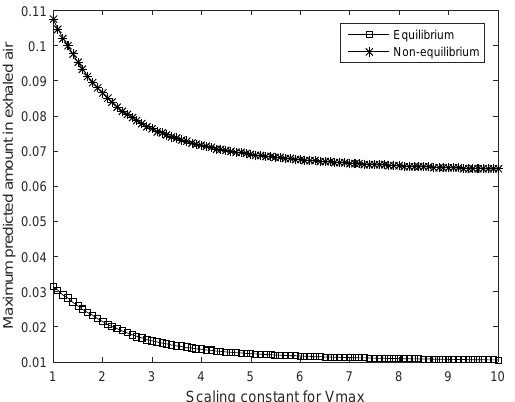
Fig. 2. Maximum model output for the amount of xylene in exhaled air for various V xyl maxc values.